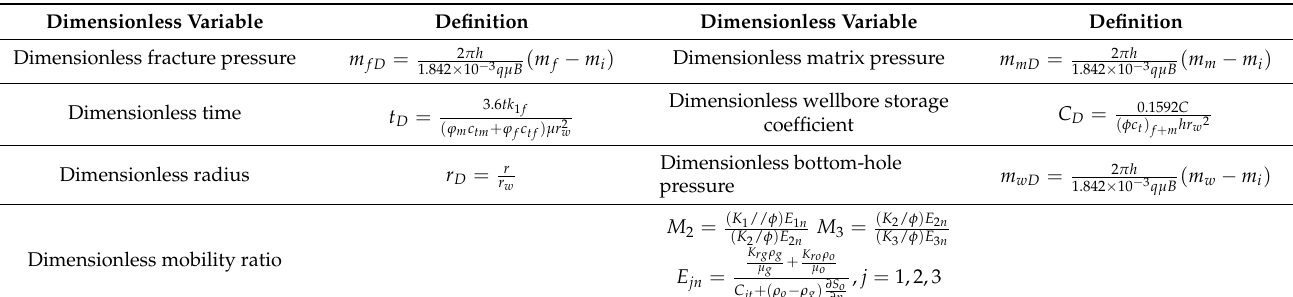
Table 1. Dimensionless variables and